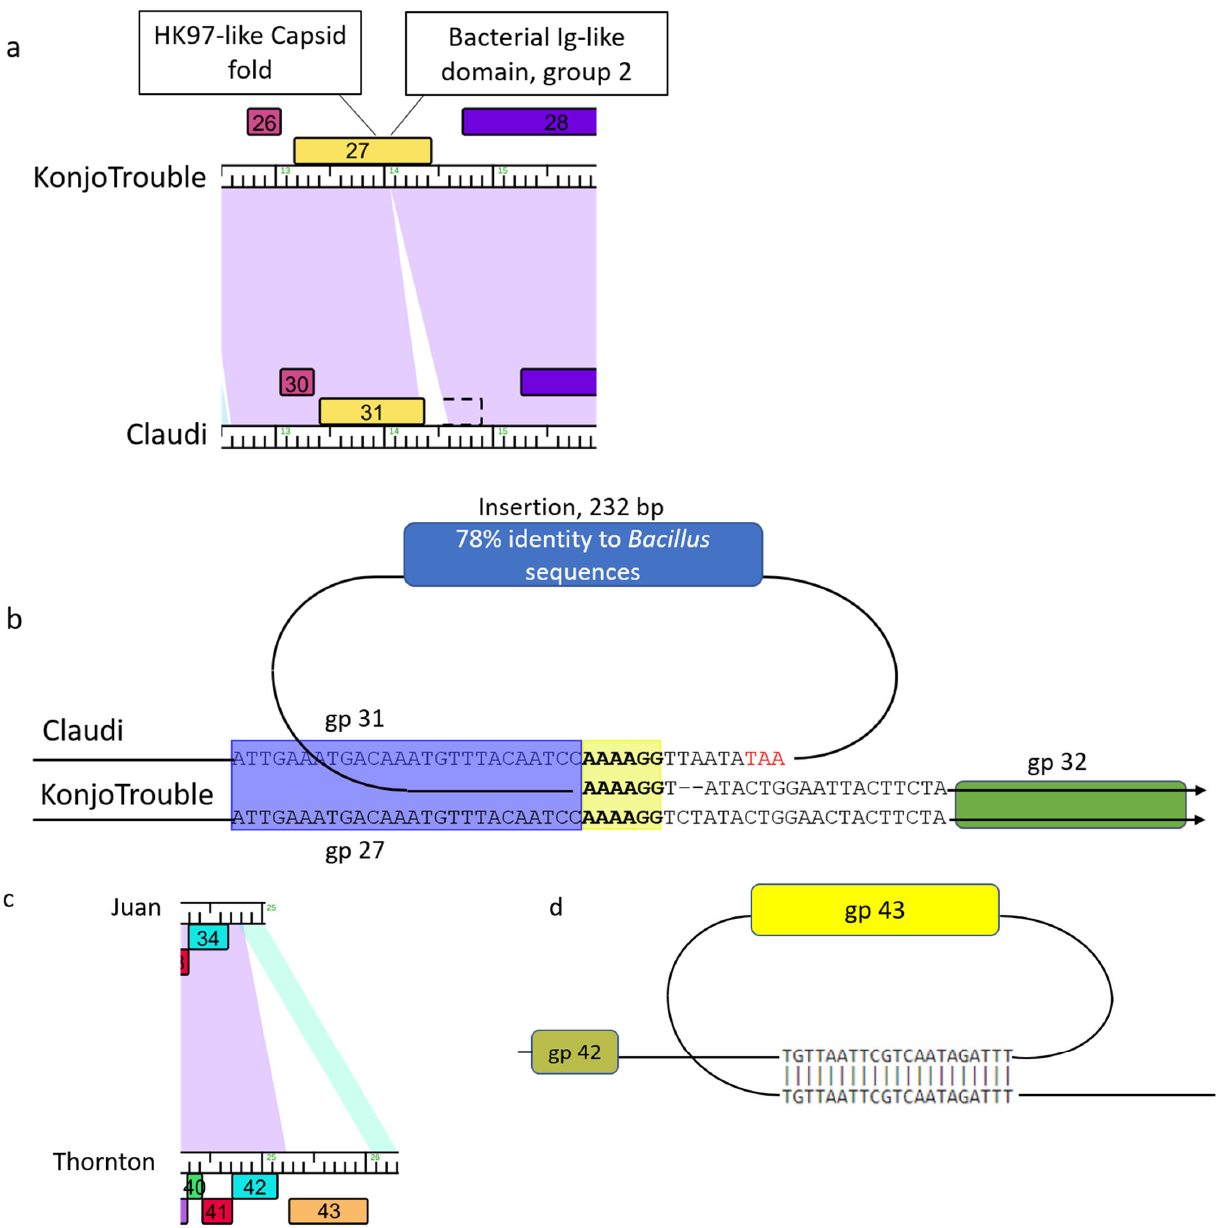
Figure 8. Sequence-directed recombination leads to protein variations and new protein functions. ( a ) Phamerator map of the capsid protein region of KonjoTrouble compared to Claudi. Colored rectangles represent protein families and purple shading between the genomes represents Blastn homology. The dotted black outline represents where the BIG2 domain is present in Claudi sequence. ( b ) Sequence alignment of the region surrounding the 232 bp insertion in Claudi compared to KonjoTrouble, which lacks this insertion. Blue and green rectangles are colored corresponding to protein family coloring in panel ( a ). The yellow shaded region shows two copies of a 6 nucleotide repeat in Claudi, and one copy in KonjoTrouble. The red TAA designates a stop codon in the Claudi sequence. ( c ) Phamerator map of the 3 ′‐ end region of Juan compared to Thornton. ( d ) Sequence alignment of the region surrounding Thornton gp 43.